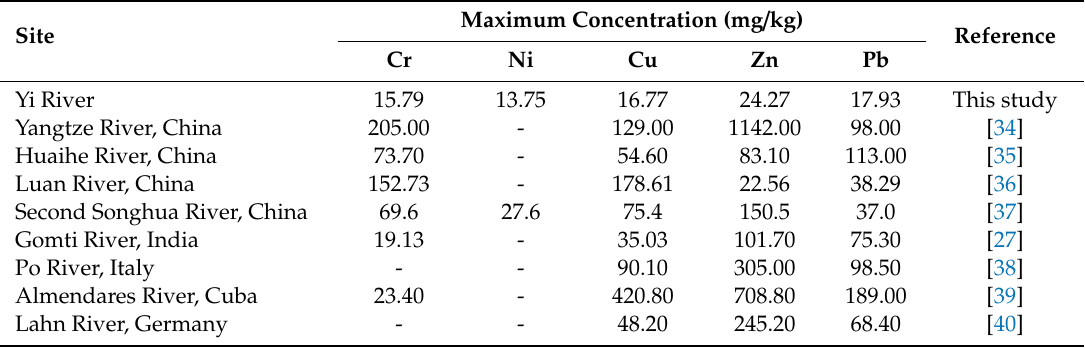
Table 7. Maximum Cr, Ni, Cu, Zn, and Pb concentrations in sediments of the selected water bodies in China from